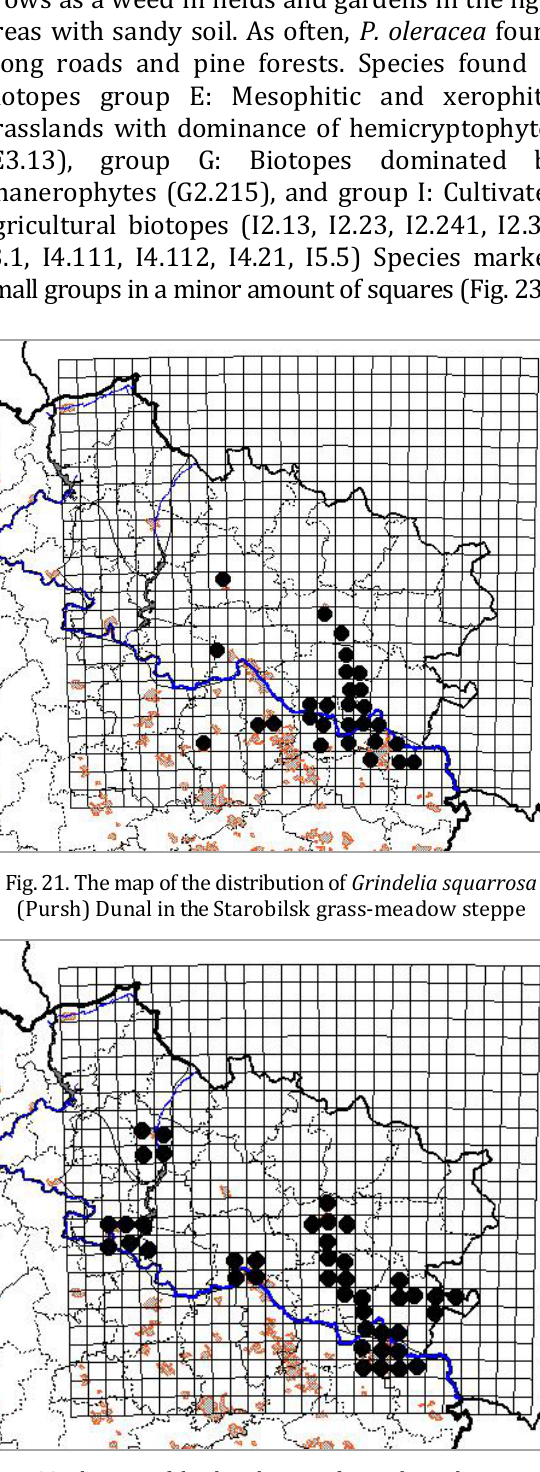
Fig. 22. The map of the distribution of Helianthus tuberosus L. in the Starobilsk grass-meadow steppe